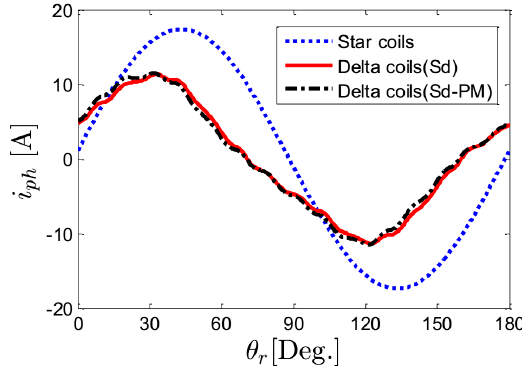
Figure 12. Currents of star and delta coils at rated conditions and optimal current angles.